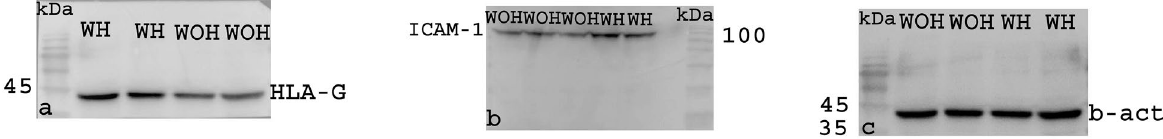
Figure 1. Comparison of ( a ) HLA-G (43 kDa), ( b ) ICAM-1 (100 kDa), and ( c ) β actin protein as control. Protein levels in western blot analysis were examined between POR patients without healthy lifestyle habit and with healthy lifestyle habit. In the ( a ) and ( b ) pictures, WH lanes belong to the POR patients with healthy lifestyle habit and WOH lanes belong to the POR patients without healthy lifestyle habit (Supplementary